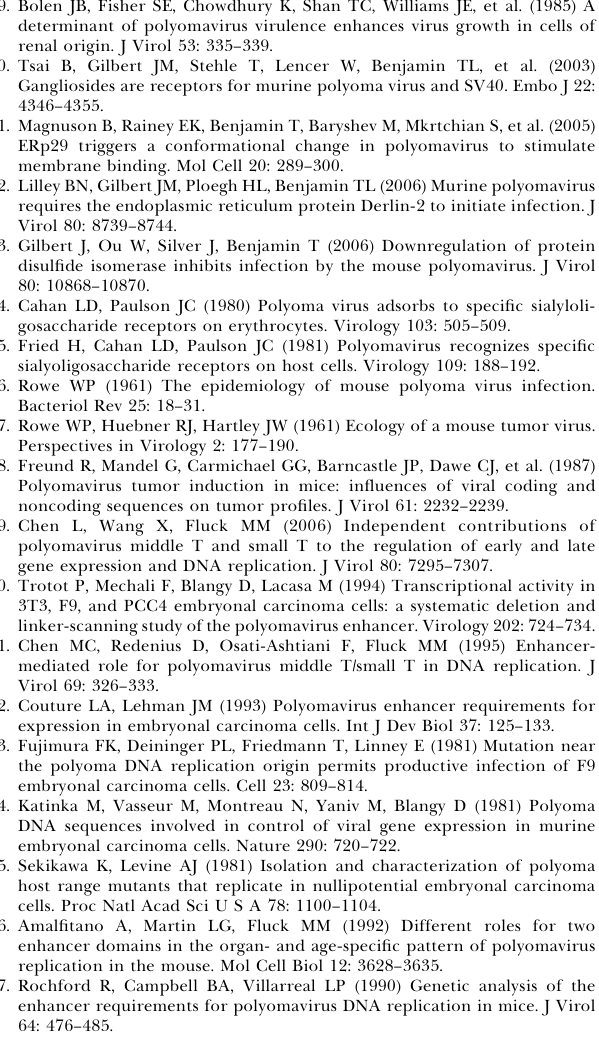
Figure S1. Nucleotide Sequences of the Noncoding Regions of Prototype Laboratory Strains (PTA, RA, and LID) and New Isolates of Polyoma Viruses (MB, Z1, Z2, H, N, D, C, and S) The sequences cover the region from the translation start site for Vp2 on the late side (nucleotide 5002; NCBI accession number J02288 for polyomavirus strain A2) to the translation start site of the T antigens on the early side (nucleotide 177 in A2). The ori-core sequence (nucleotides 5276–44); [42] is boxed. ; marks nucleotide 1 in A2.